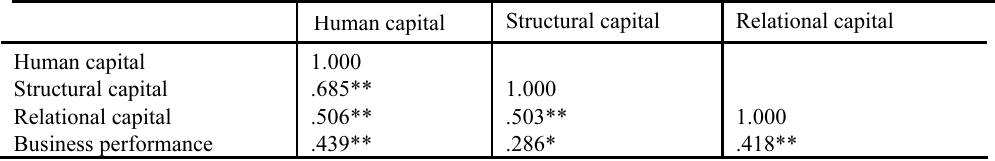
Table 3. Correlation matrix of measured dimensions Human capital Structural capital